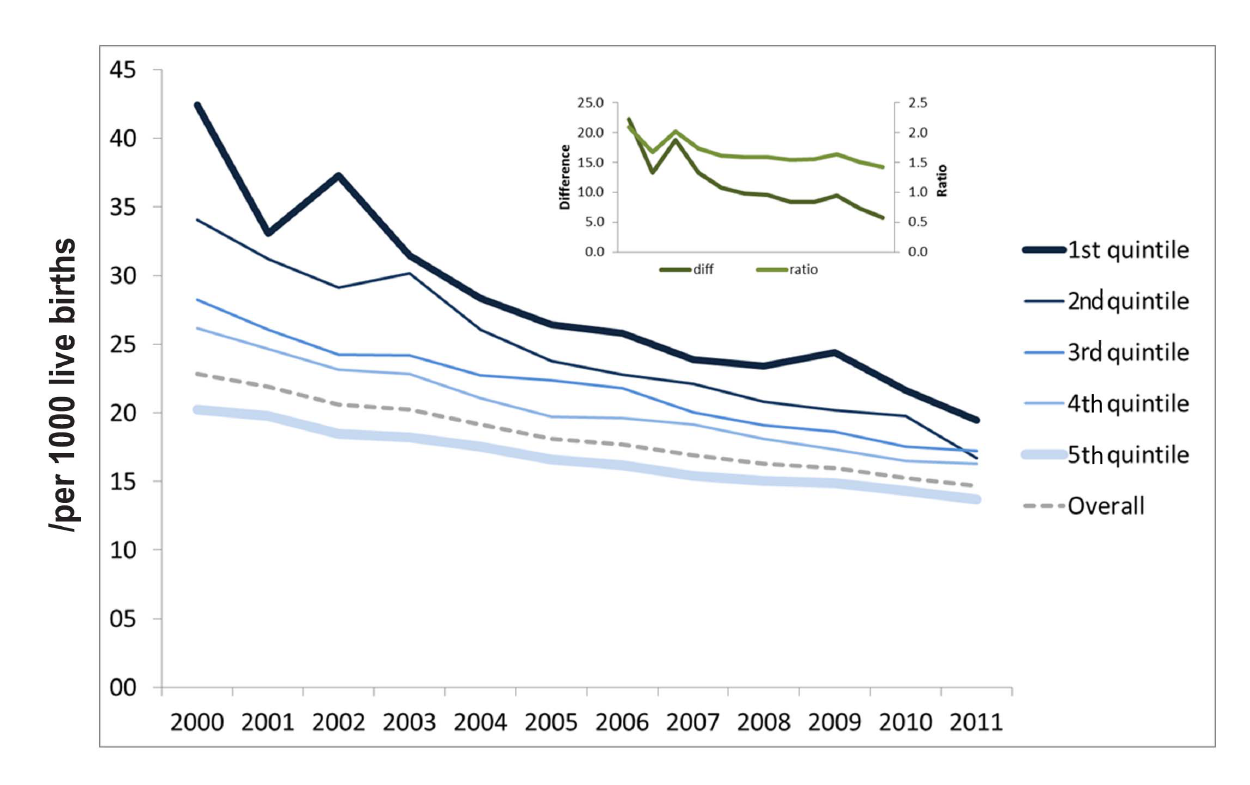
Figure 2. Under-five mortality rates according to municipal human development index (HDI-M) quintiles of the 5,507 Brazilian municipalities (Data from the Mortality Information System – SIM [12] ). The graph inset reflects the absolute differences and ratios between the U5MRs of the poorest and richest quintiles.